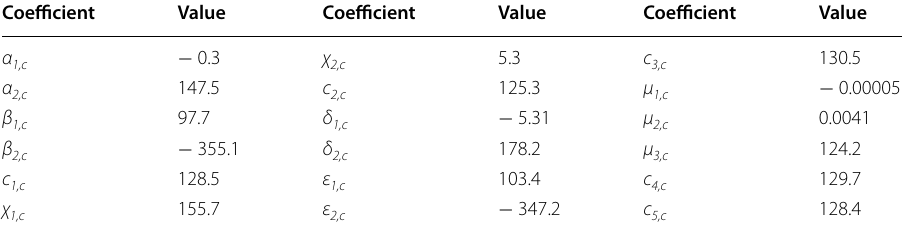
Fig. 8 Responsivity of photodetector and the spectral power distribution of the white LED sources with electrical-thermal effects